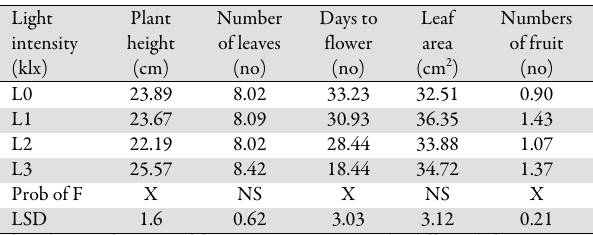
Table 2. Effect of different light intensities on the vegetative growth of the okra in the pot experiment